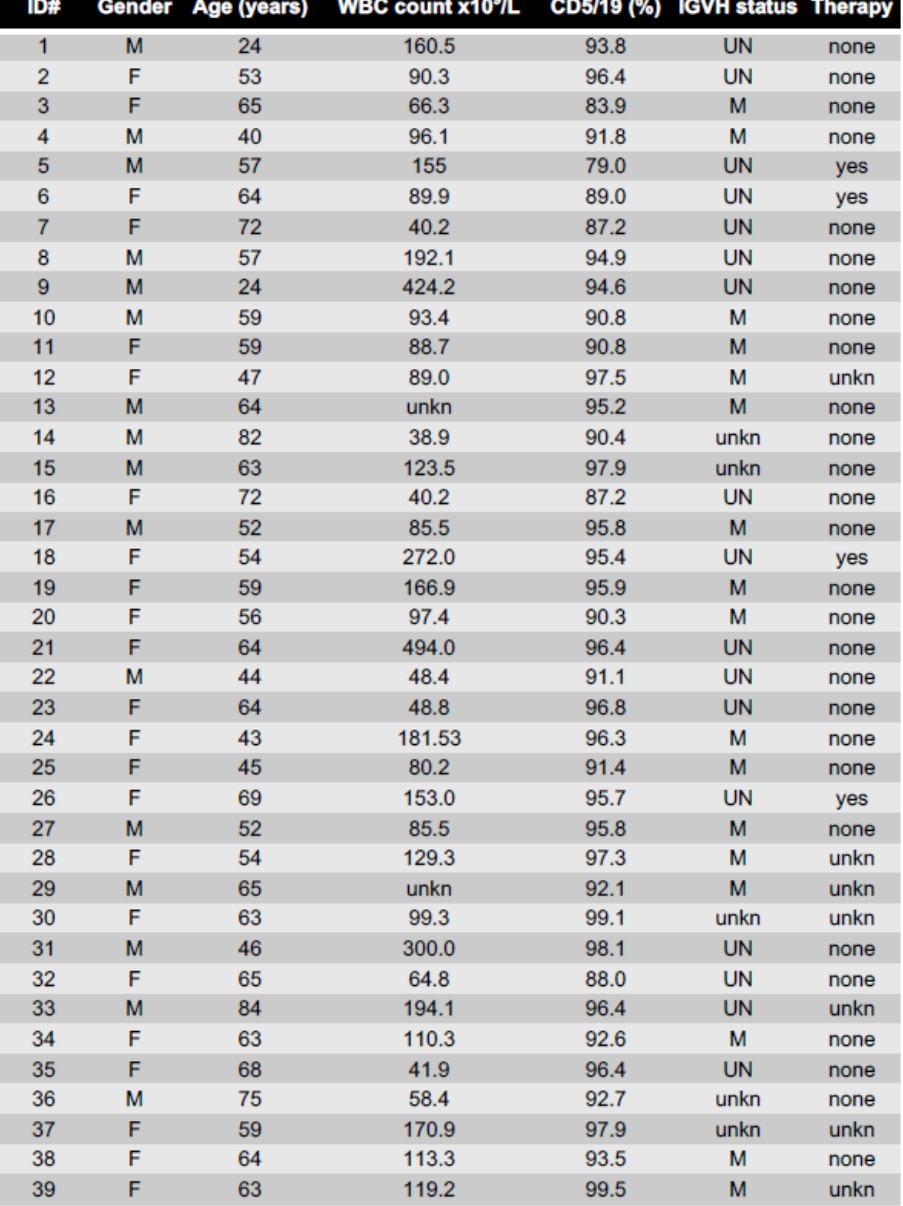
Figure 1. Patient Figure 1. Patient characteristics.